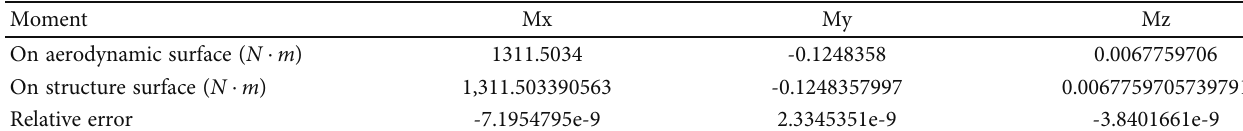
Table 2: The comparison of total torque.